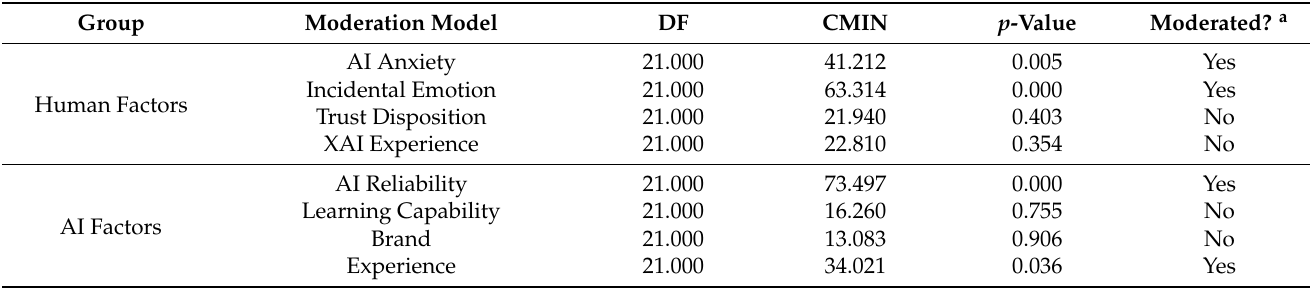
Table 10. Global multi-group moderation effect analysis.